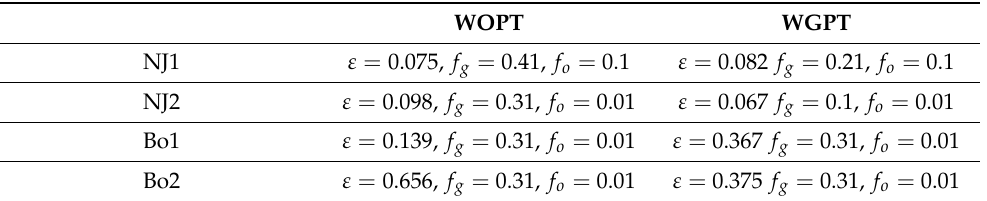
Table 1. Best matches in oil and gas produced volumes, obtained for the selected North Jens and Bo wells using the corresponding relative permeabilities’ parameters f g and f o .